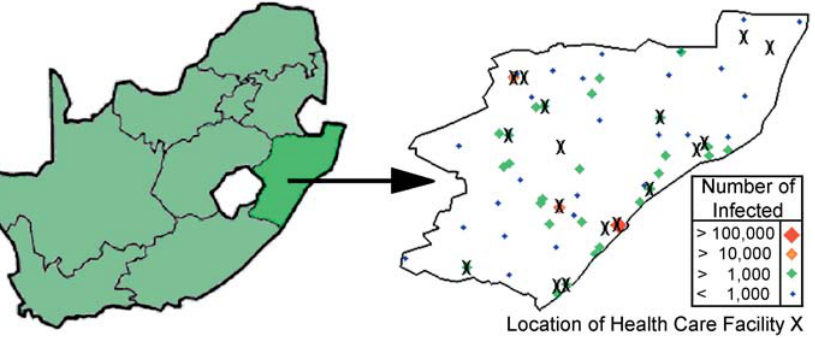
Figure 1. Map of South Africa Indicating the Location of the KwaZulu–Natal Province and Map of KwaZulu–Natal Black crosses indicate the location of the 17 HCFs that have been designated for ARV rollout by the South African government, and the spatial distribution of communities distinguished by the number of individuals infected with HIV (by both size and color). Durban (represented by the large red diamond) is the capital city of the province and has more individuals with HIV than any other community. Pietermaritzburg and Newcastle (represented by orange diamonds) have the next greatest numbers of individuals with HIV. DOI: